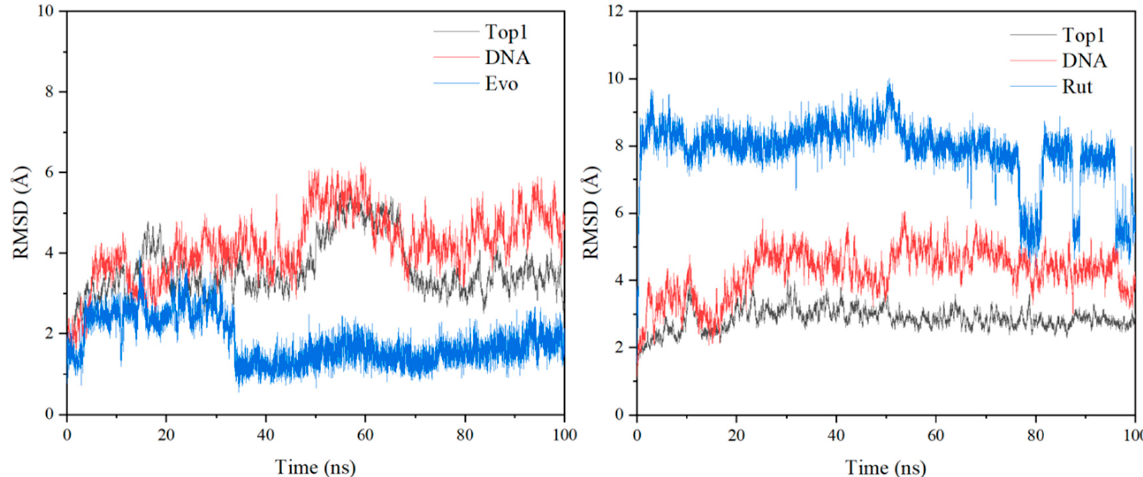
Figure 5. The root-mean-square deviation (RMSD) values of heavy atoms of protein, DNA, and inhibitor in 100 ns molecular docking simulations for the TOP1/EVO system ( left ) and TOP1/RUT system ( right ).